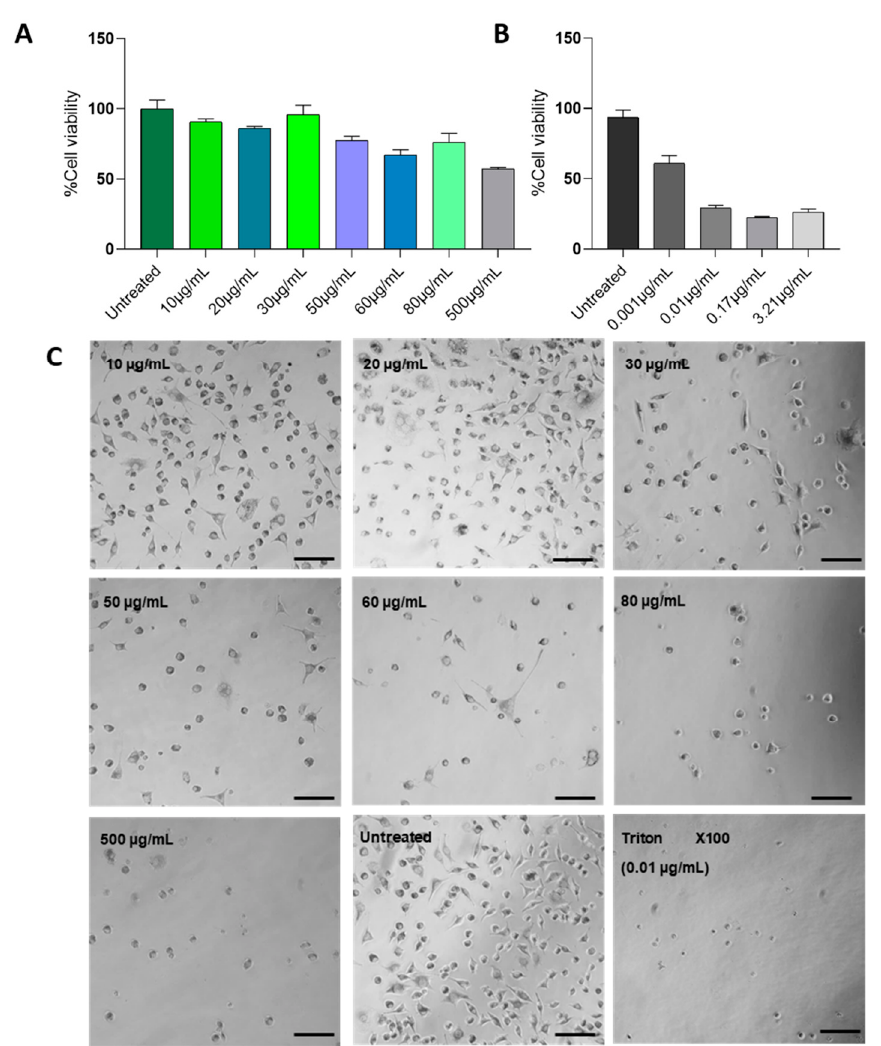
Figure 1. ( A ) Cell viability MTT assay results of the in vitro cytotoxicity of AgNPs against L929 cells for 24 h. ( B ) Triton X100 positive cytotoxicity control. Data are expressed as mean ± SD of three experiments. The percentage of cytotoxicity is expressed relative to untreated controls ( A , B ). ( C ) Phase-contrast micrographs of in vitro cell cytotoxicity assessment of S. queretaroensis -based AgNPs. Scale bar: 200 µM.